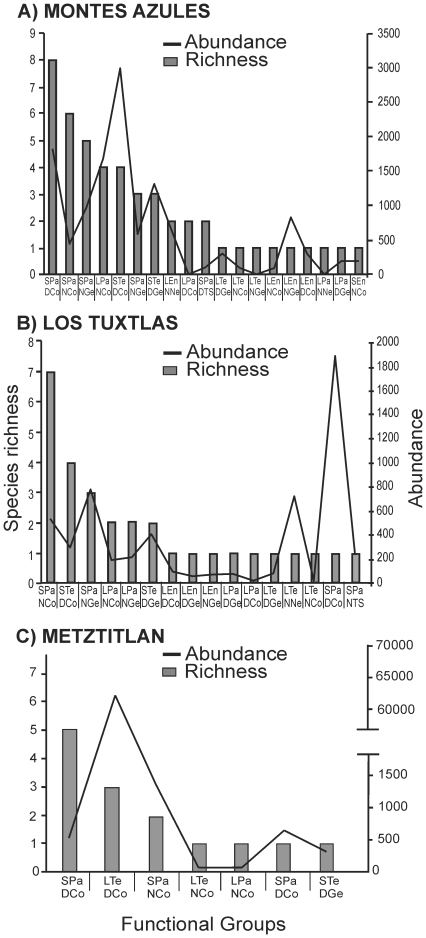
Species richness and number of dung beetles per functional
group.The figure shows the communities from (A) Montes Azules, (B) Los Tuxtlas
and (C) Barranca de Metztitlán. The names of the functional
groups are combinations of the following characteristics:
S = small, L = Large,
Pa = paracoprid,
En = endocoprid,
Te = telecoprid, D = diurnal,
N = nocturnal,
Ge = generalist,
Co = coprophage,
Ne = necrophage, and
TS = trophic specialist.